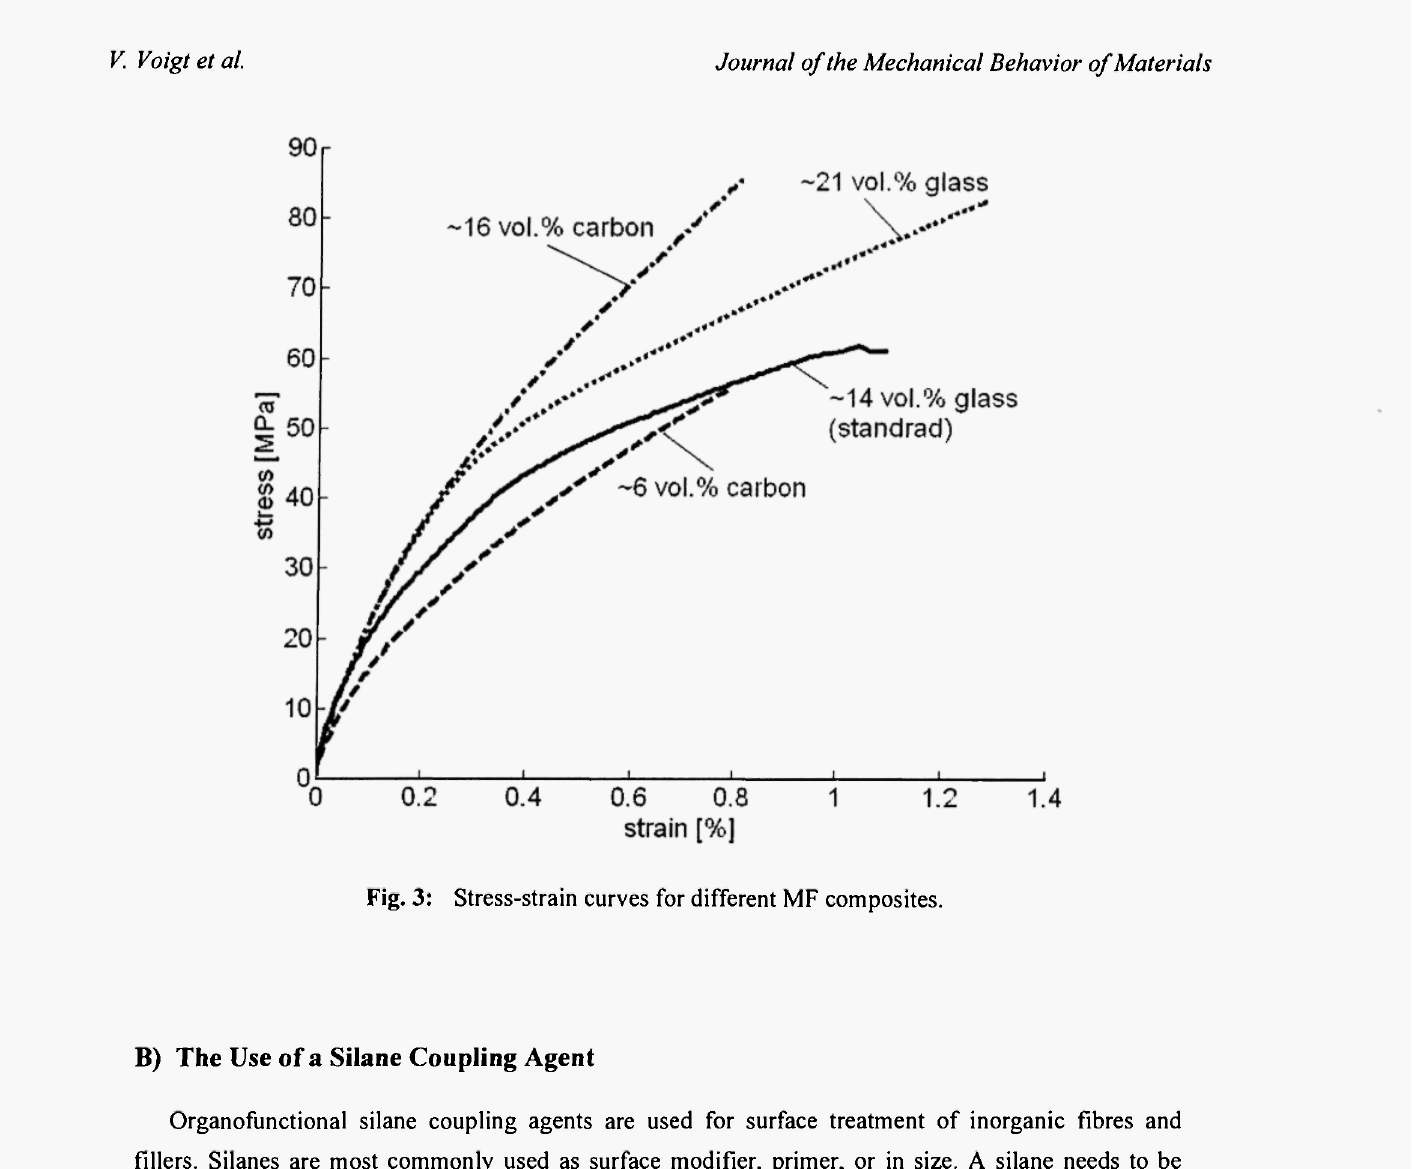
Fig. 3: Stress-strain curves for different MF